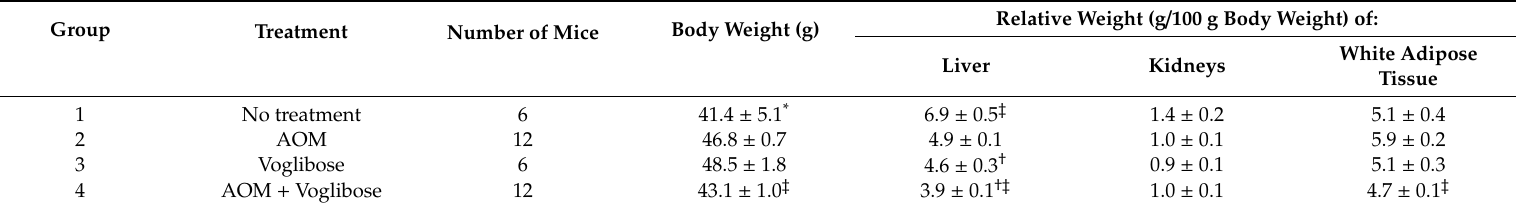
Table 1. General observations of the experimental mice.